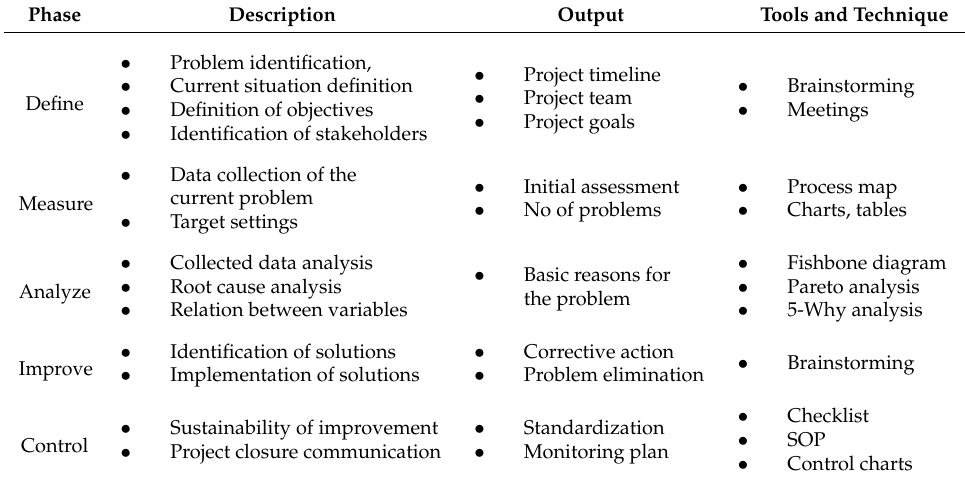
Table A4. DMAIC Detail